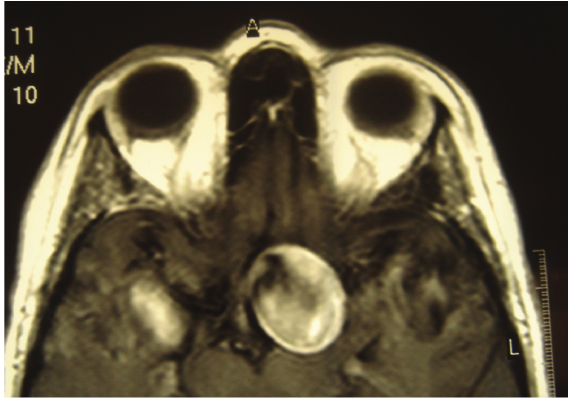
Figure 2: Axial T1-weighted MRI revealing the giant internal carotid aneurysm.